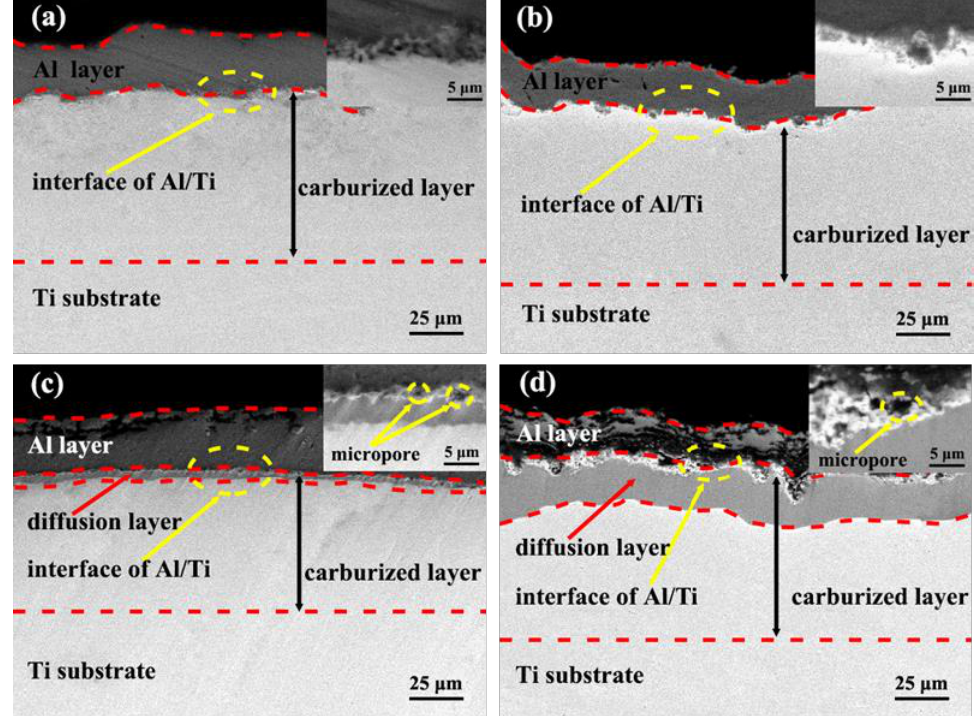
Figure 7. The cross-sectional back-scattered electrons (BSE) micrographs of the samples: (a) S1, (b) S2, (c) S3, (d) S4.